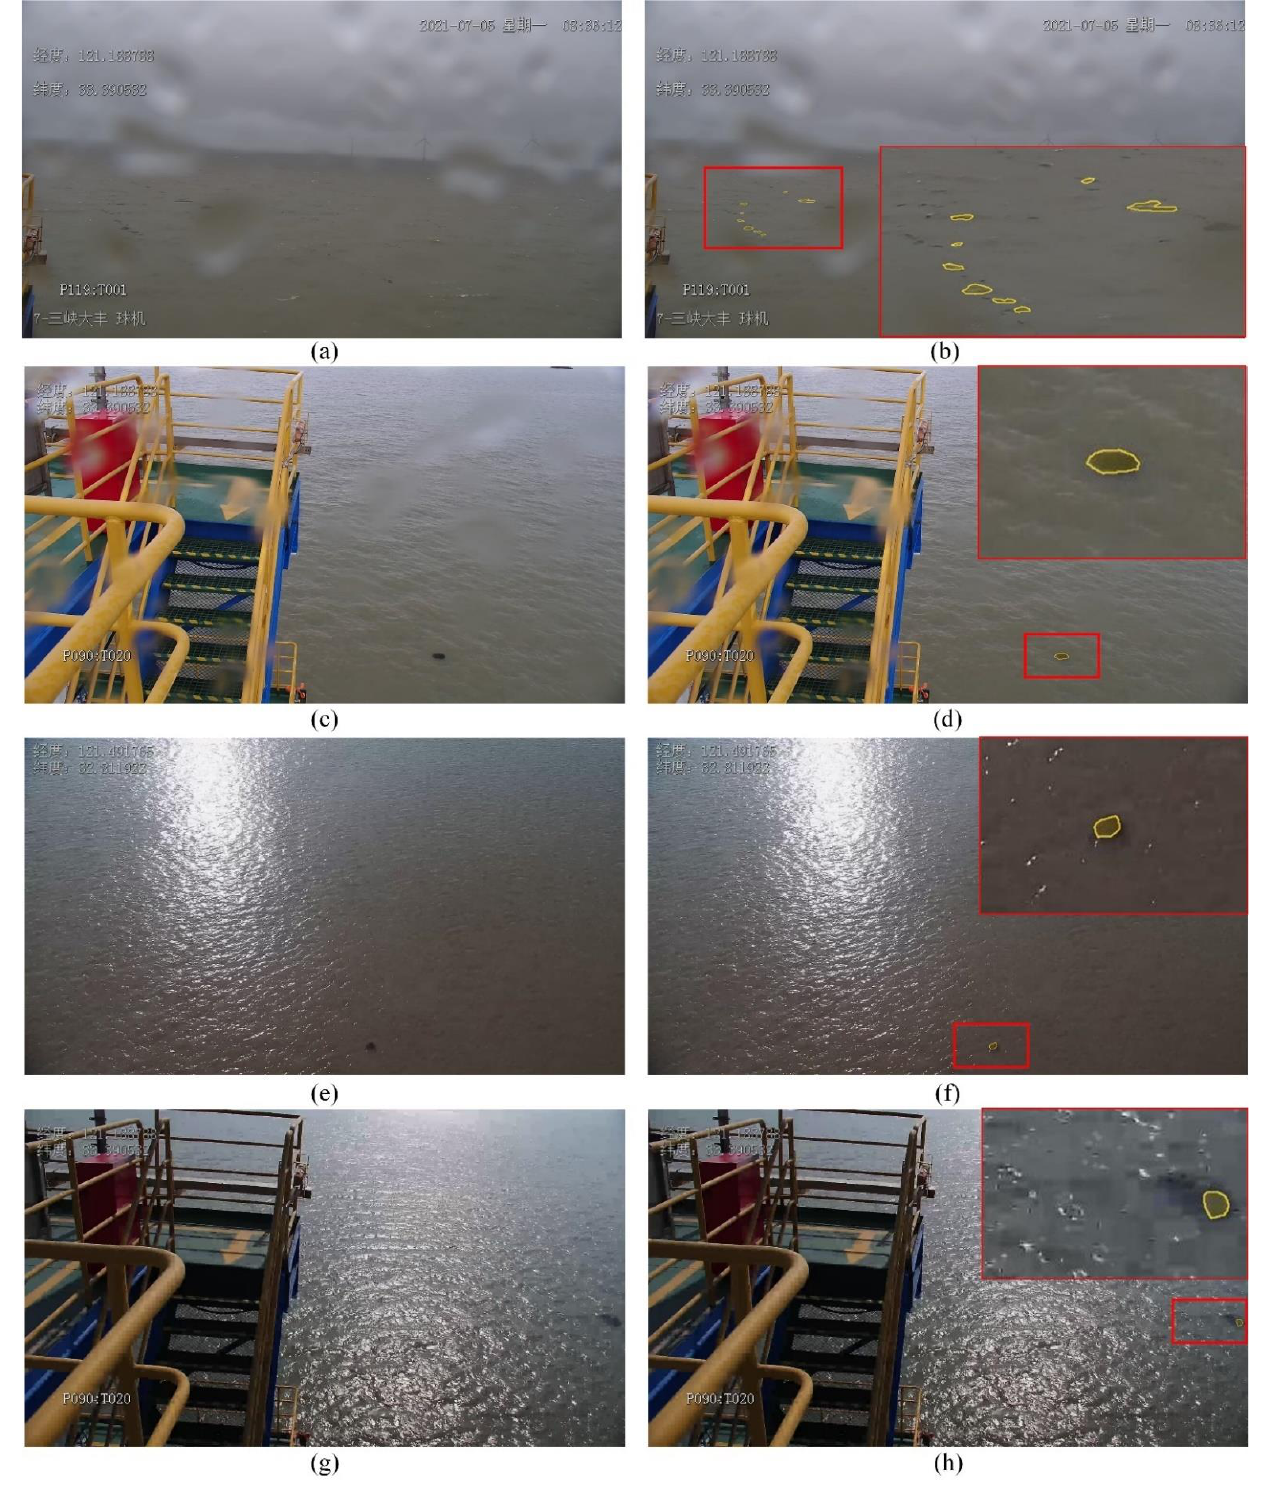
Figure 22. The results of AlgaeFiner in rainy and sun reflection scenes: ( a , c ) are the rainy scene, and ( e , g ) are the sun-reflection scene, and ( b , d , f , h ) indicate the detection results of AlgaeFiner corresponding to the images ( a , c , e , g ).